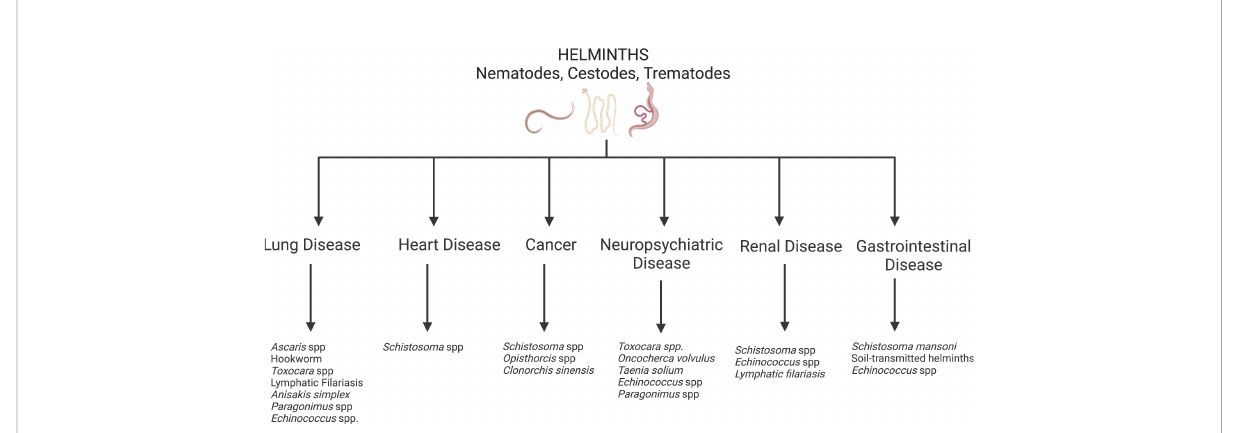
FIGURE 1 Helminth induced non-communicable diseases. Created with